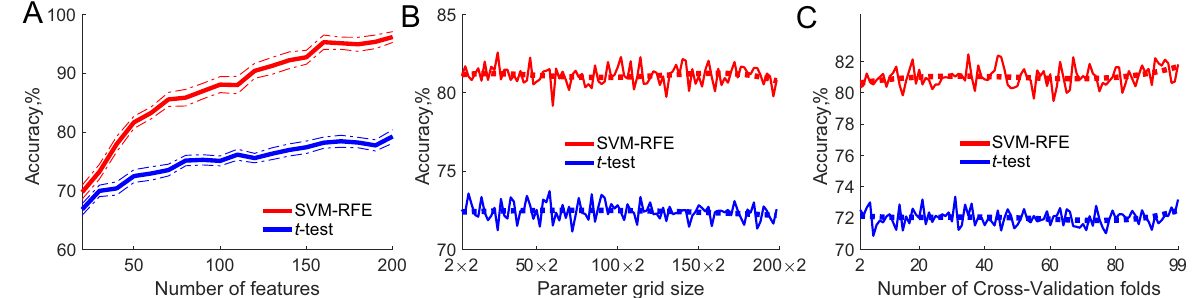
Fig 5. Other factors apart from sample size influencing overfitting when K-Fold CV is used. SVM-RFE and t -test feature selection, logistic regression classification, and sample size fixed at N = 100. A : Feature number manipulated from 20 to 200. B : Parameter tuning grid size manipulated from 2 × 2 to 200 × 2 with penalty set to L 1 , L 2 and C = e i , where i varied from − 4 to 4. Thick lines show fitted 5th order polynomial trend. C : Number of CV folds varied from two-fold to leave-one-out. Thick dashed lines show fitted 5 th order polynomial